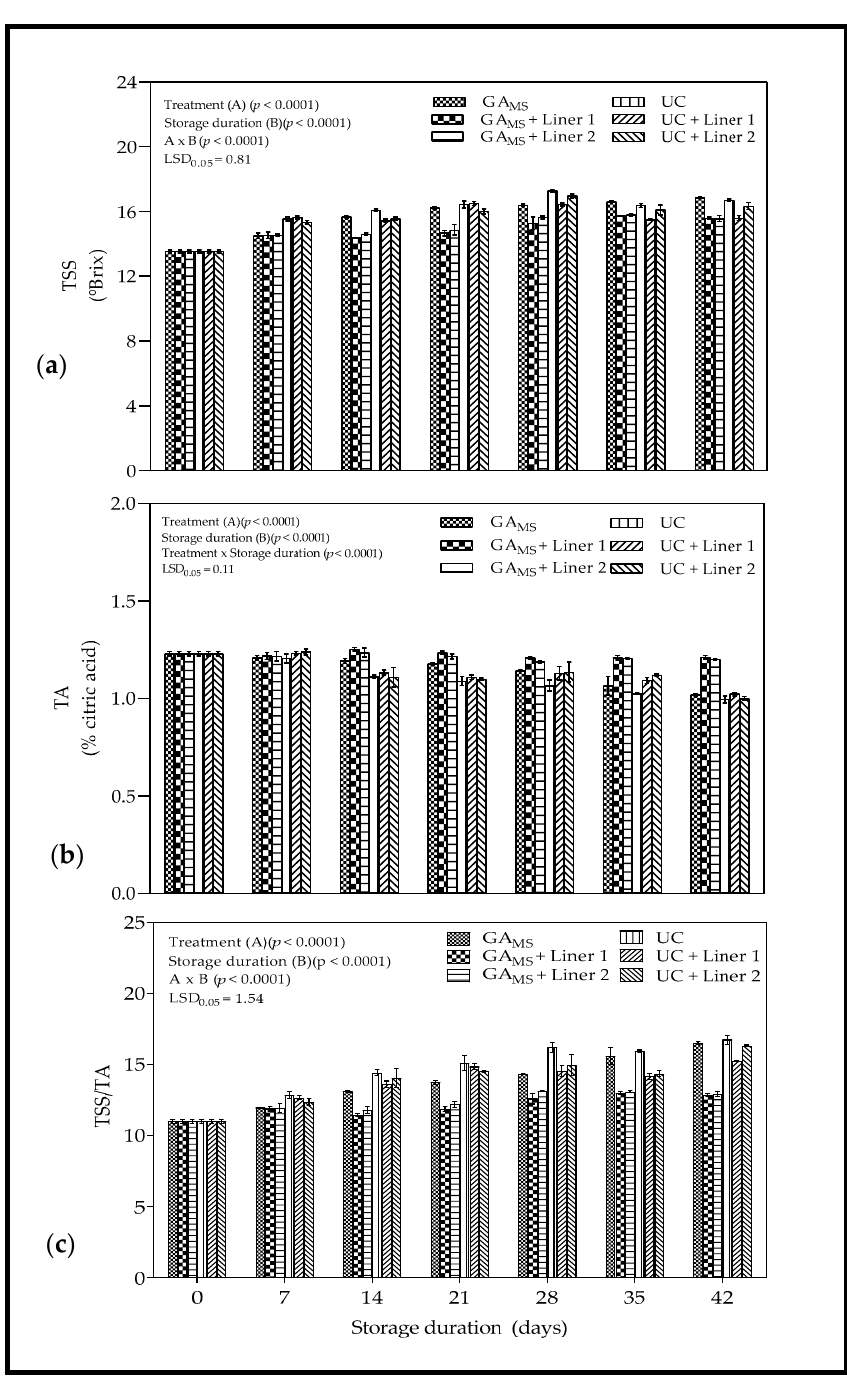
Figure 7. ( a ) Total soluble solids (°Brix), ( b ) titratable acidity (% citric acid) and ( c ) TSS/TA ratio of ‘Wonderful’ pomegranate coated and packaged in different polyliners and stored (5 ± 1 °C, 95 ± 2% RH) for 42 d. GA MS —gum Arabic (0.5% w / v ) and maize starch (0.5% w / v ); Liner 1—Xtend ® liner (20 µ mm perforations); Liner 2—perforated liner (4 mm perforations); UC—uncoated fruit. LSD 0.05 represents least significant difference ( p <